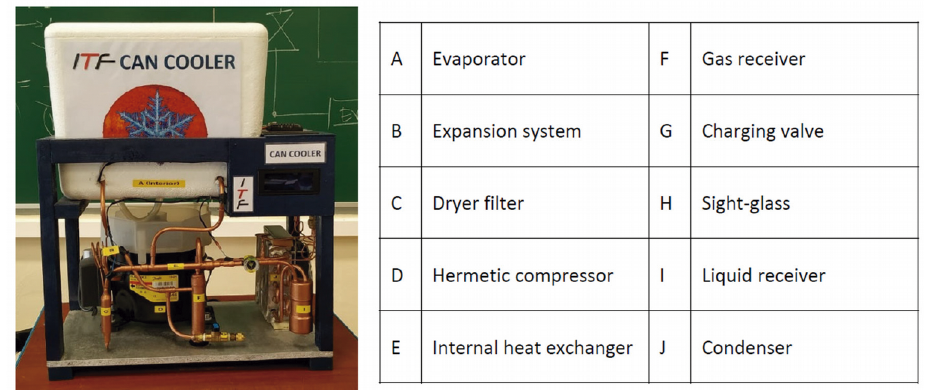
Figure 3. Main elements of the prototypes